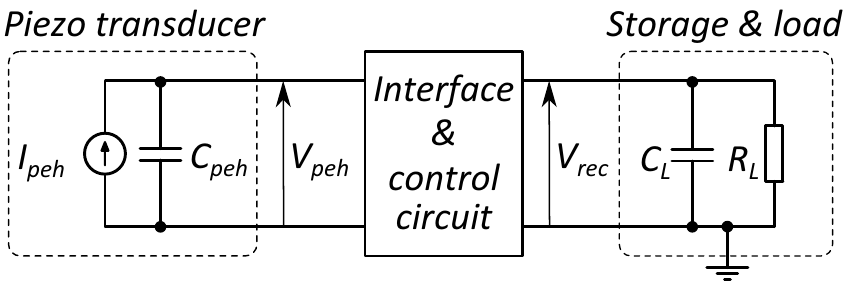
Figure 1. Piezoelectric harvesting